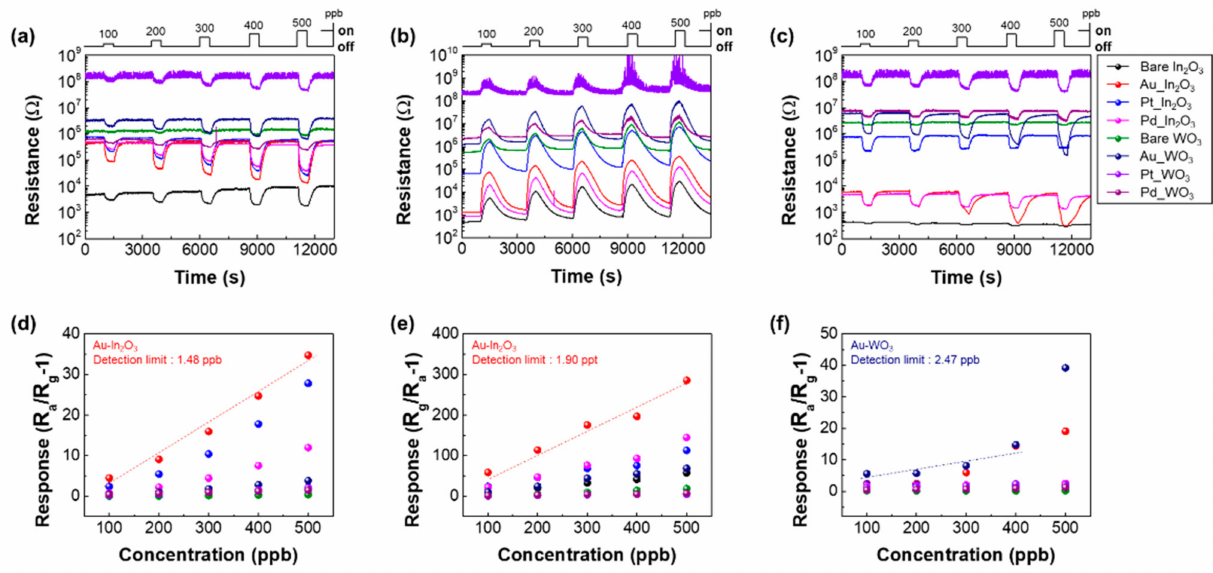
Figure 6. Response of the 2 × 4 sensor array to 100–500 ppb ( a ) CH 3 COCH 3 , ( b ) NO 2 , and ( c ) H 2 S at 300 ◦ C, 150 ◦ C, and 250 ◦ C, respectively. Theoretical detection of limit of 2 × 4 sensor array to 100–500 ppb ( d ) CH 3 COCH 3 , ( e ) NO 2 , and ( f ) H 2